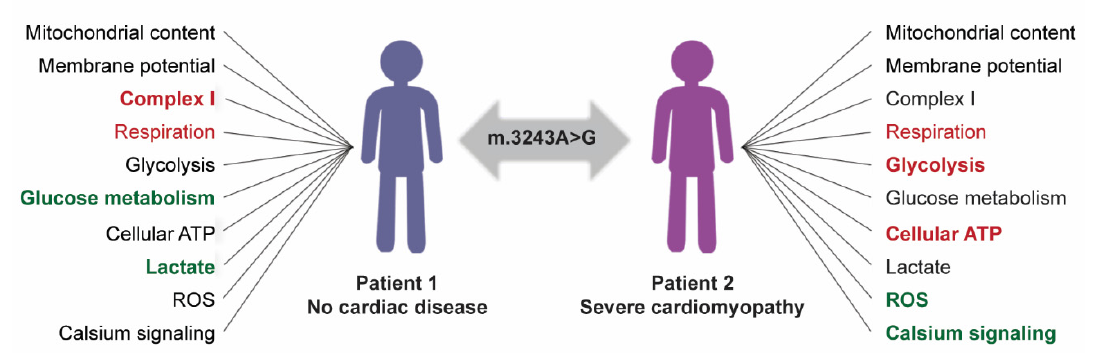
Figure 7. Summary of the effects of high m.3243A>G mutation load on two independent patients. Decreased functions indicated in red, unchanged in black, and increased in green fonts. The different responses between patients indicated in bold. mt = mitochondrial.